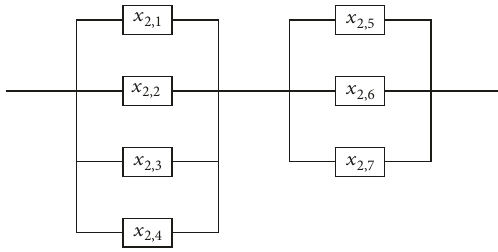
Figure 7: Network ambiguity resolution module 𝑀 𝑁,2 . The first block of this figure represents the ambiguity processing algorithms and the second block is the ambiguity quality indicators.